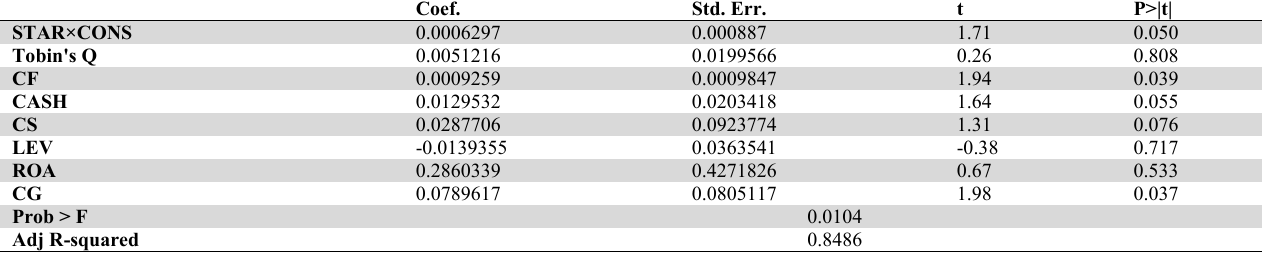
Regression results concerning the impact of both strategy and conservatism on the investment level